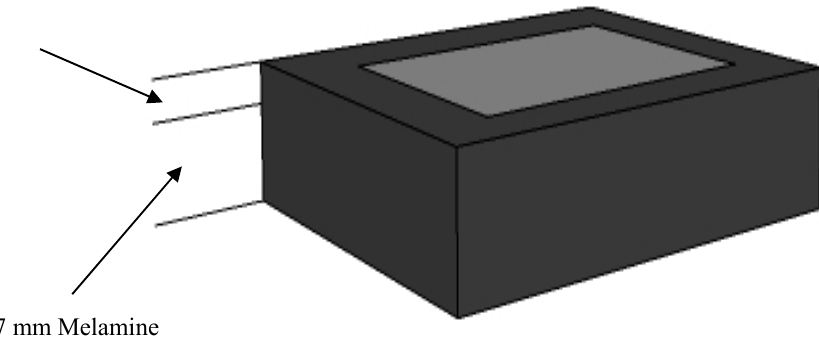
Figure 1. Milk-melamine sample holder (e.g., 3 mm-thick milk and 7 mm-thick melamine layers). The light grey area shows the sample surface (30 mm × 30 mm).